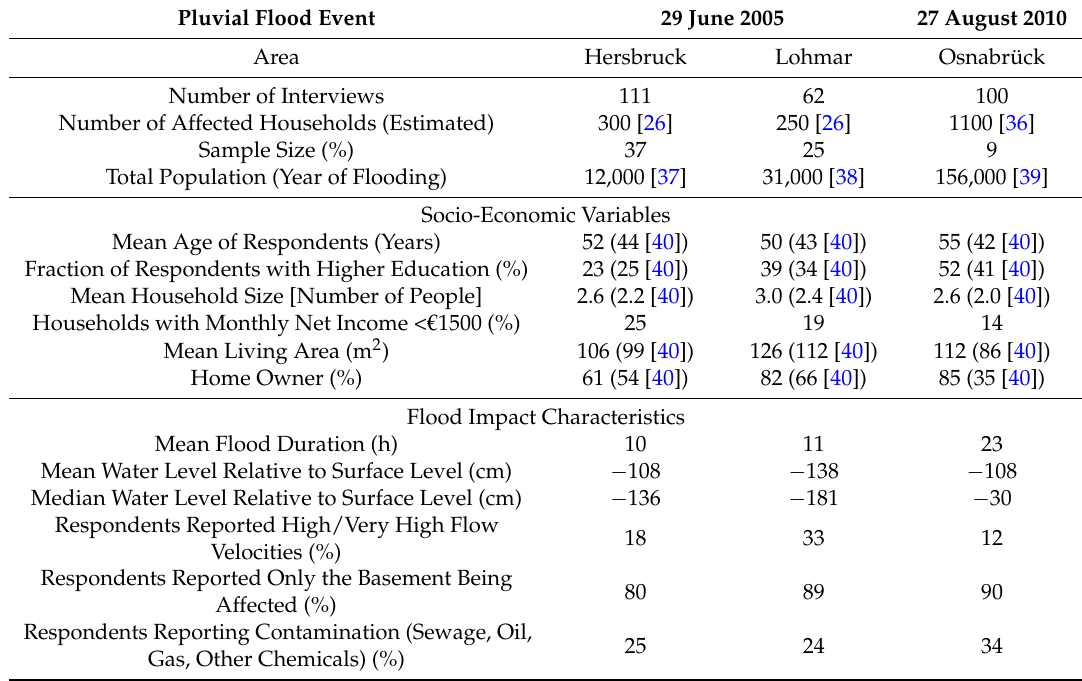
Table 1. Socio-economic variables and flood characteristics for the three study areas. The values in brackets show the reference values based on data from the census in